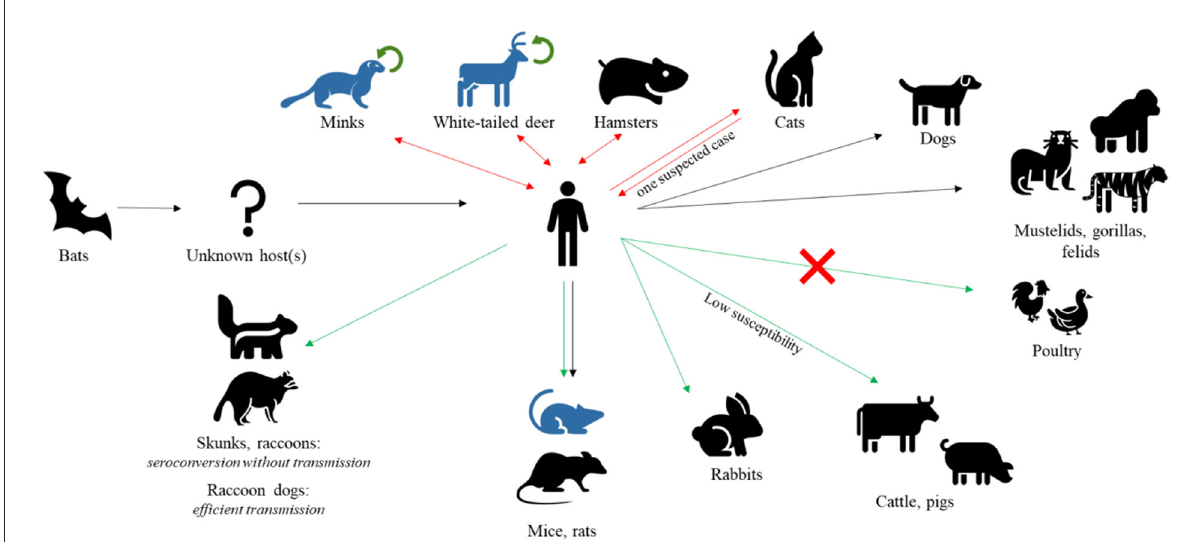
FIGURE1 SARS-CoV-2 hosts. After jumping to human from bats, SARS-CoV-2 has been found in several other mammal species, naturally or experimentally infected. Black arrows represent natural infections, red double arrows represent natural infections with demonstrated reverse spillover to humans, green arrows represent experimental infections, and green circular arrows represent demonstrated intra-species circulation. Species with known adapted variants are indicated in blue. Notably, poultry are found to be insensitive to viral infection.